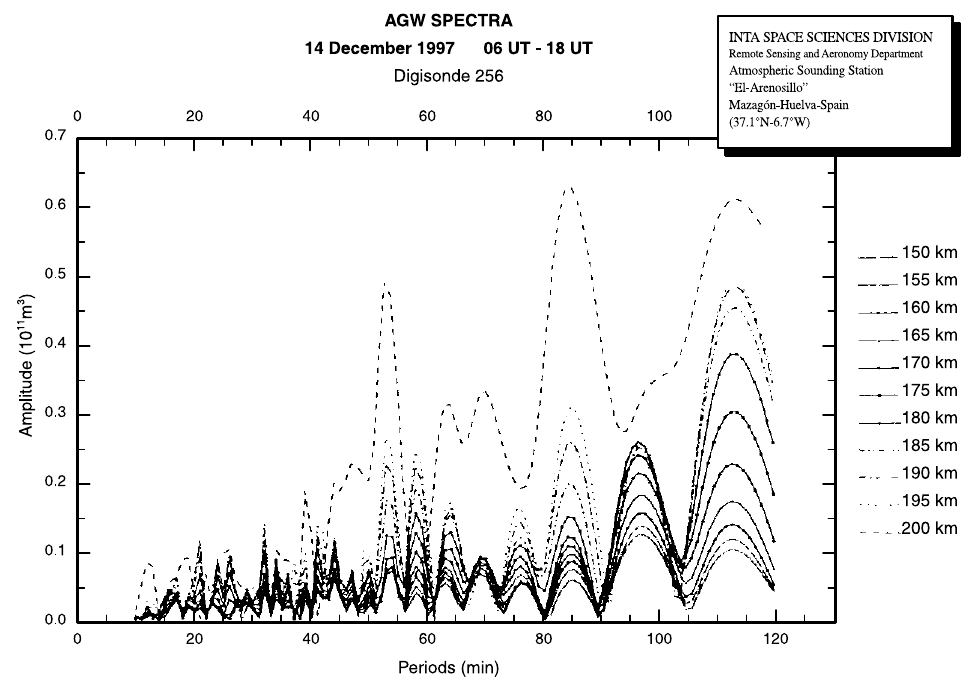
Fig. 14. Atmospheric Gravity Wave spectra in the variations of electron concentration on the fixed levels. Digisonde-256, El Arenosillo, Spain (37.1 ° N, 6.7 ° W), December 14, 1997, 06UT-18 UT (Boska et al ., 1999)